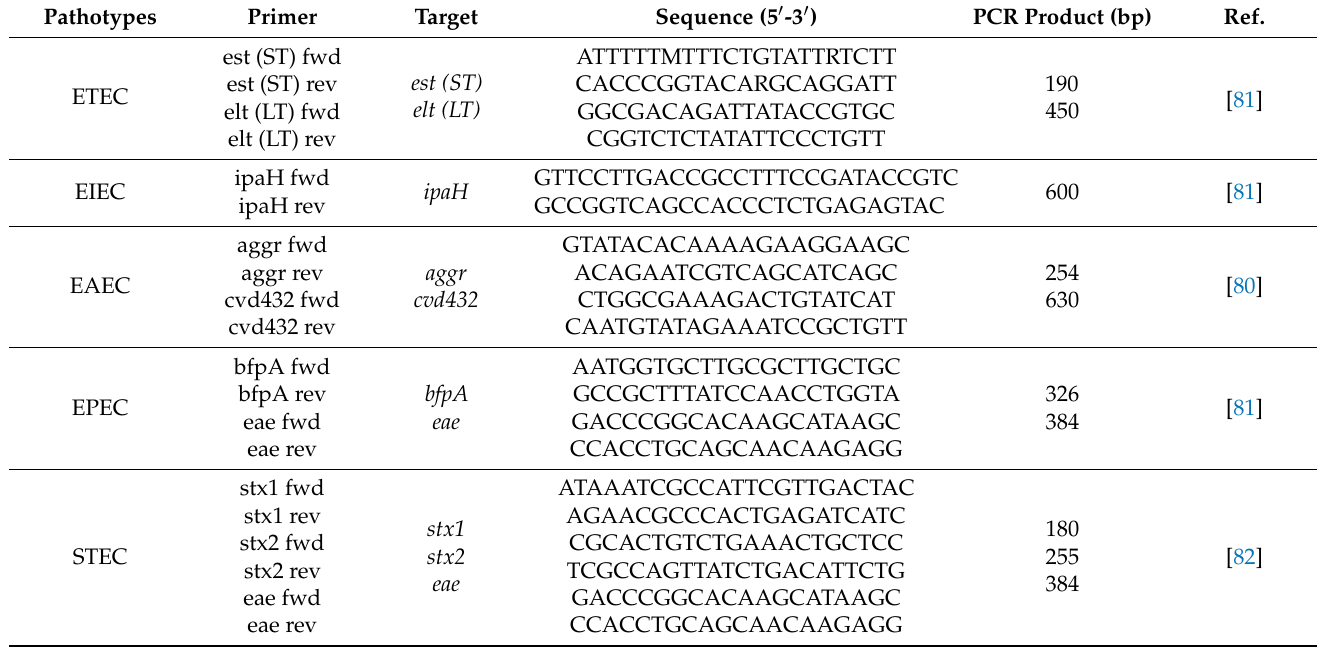
Table 11. List of primers used for the determination of